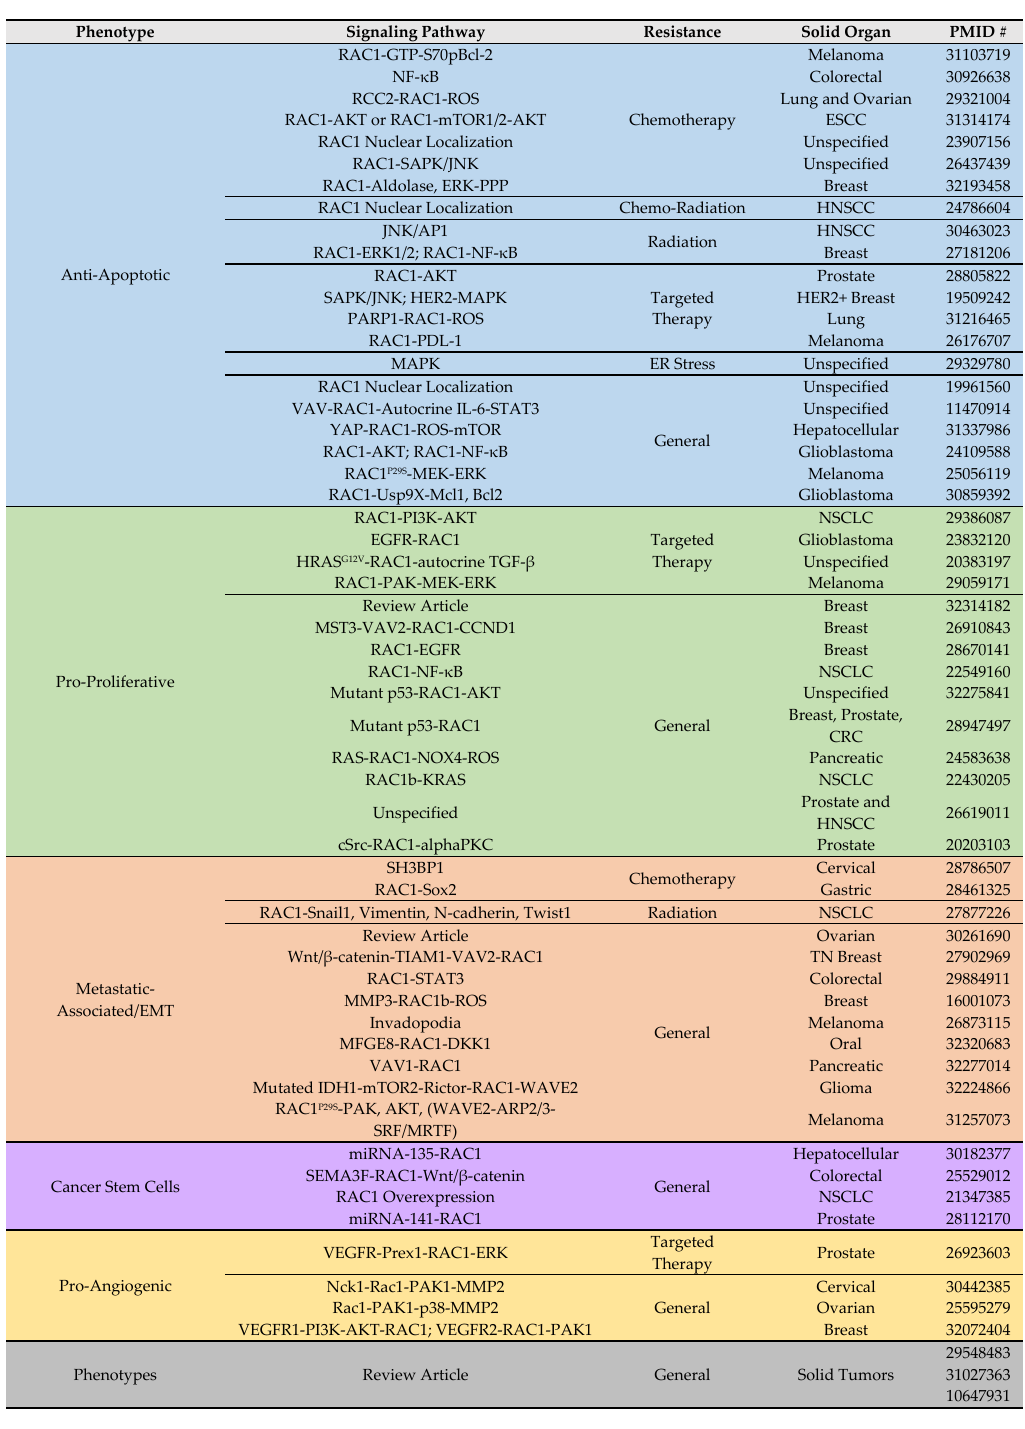
Table 1. Involvement of ras-related C3 botulinum toxin substrate 1 (RAC1) in solid tumors: a survey of the current literature. This table provides a bird’s eye view of the phenotypes regulated by RAC1 and its downstream signals in different solid tumors pertaining to the development of various resistances.